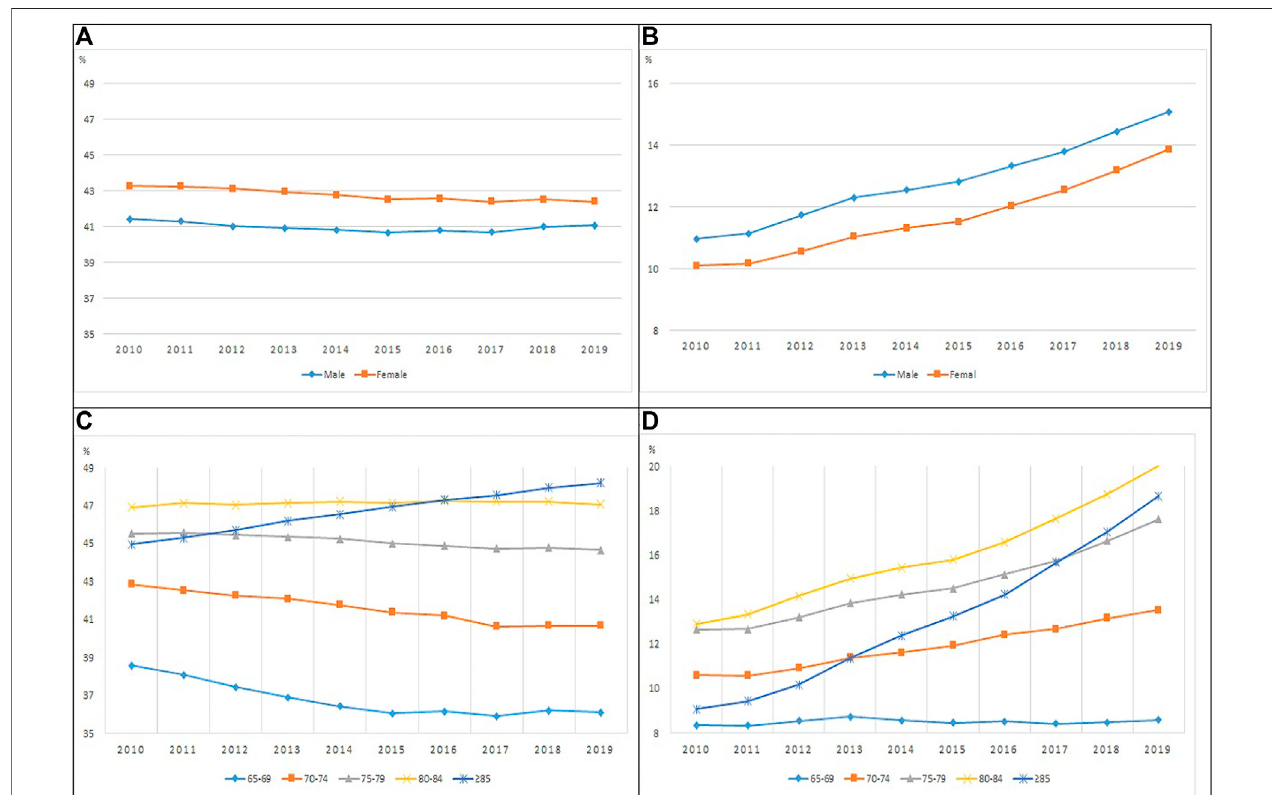
FIGURE 2 | The proportion of polypharmacy and hyper-polypharmacy among ≥ 90 days use elderly by sex and age group (A, C) Polypharmacy, (B, D) Hyper- polypharmacy).